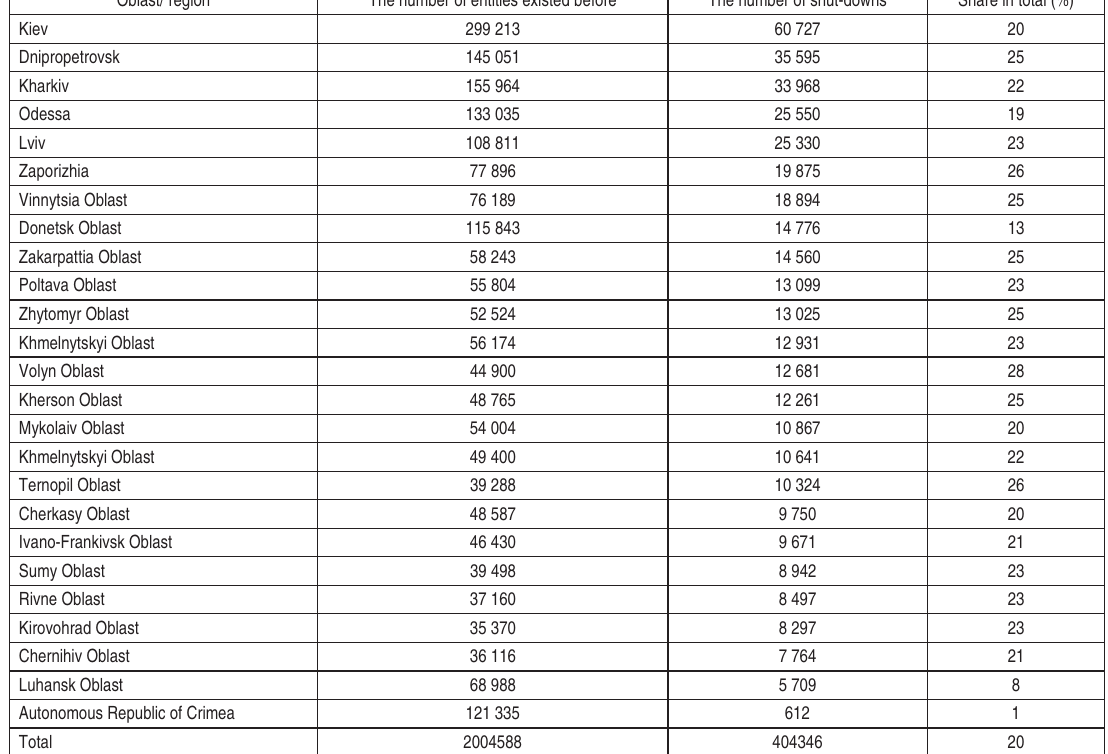
Table 2. The data about self-employed entities shut-downs in Ukraine, rated by the mortality dynamics (period from December 27, 2016 till December 5,